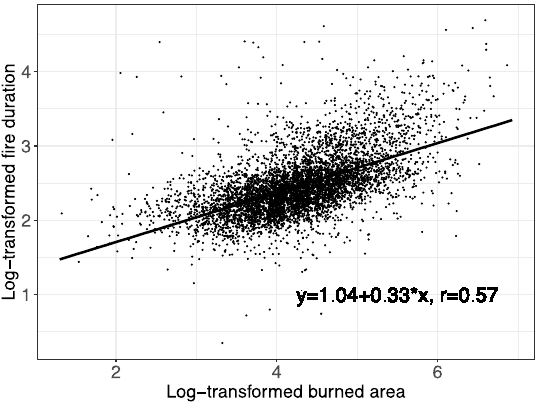
Figure 6. Scatterplot of log-transformed fire duration against log-transformed burned area.